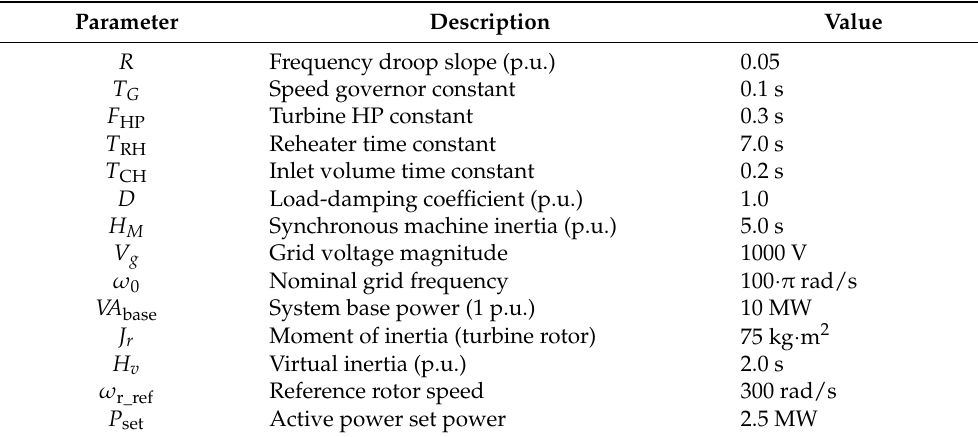
Table 1. Circuit and control parameters for the